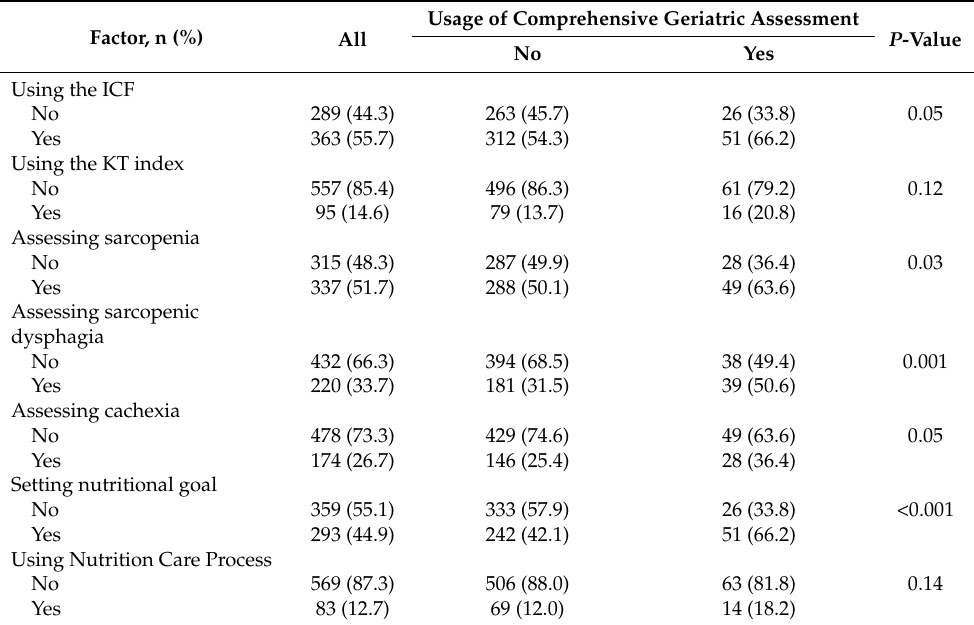
Table 2. Univariate Analysis of Factors Associated with Usage of Comprehensive Geriatric Assessment.